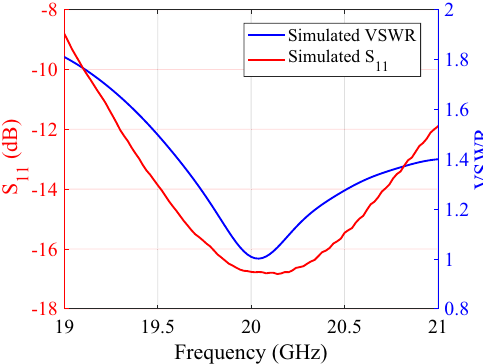
Figure 9. Predicted S 11 and VSWR for the truncated RCA.